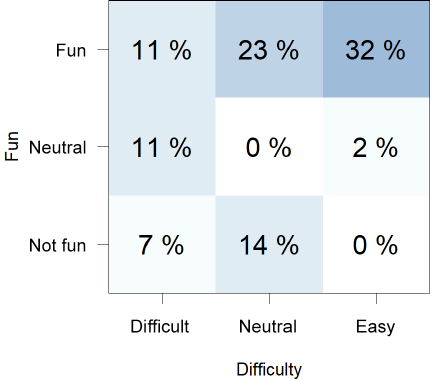
Figure 12. Percentage of participants who chose a certain cate- gory for the difficulty ( x axis) and fun ( y axis) of the game. Darker colours indicate that more participants chose these